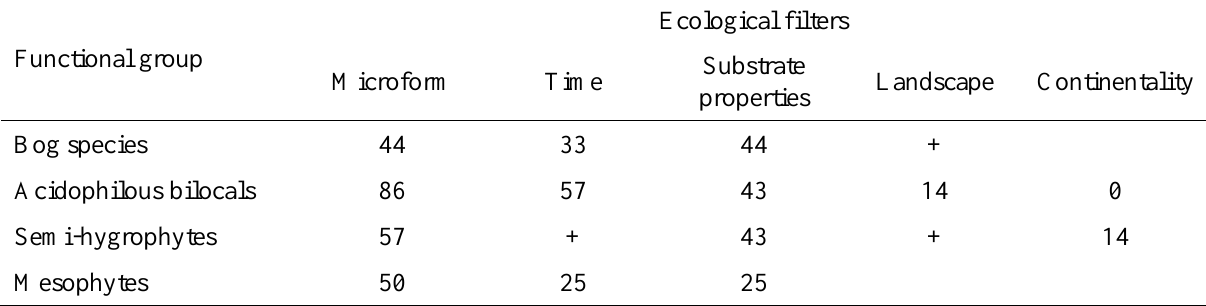
Table 3. Percent of core species models (Table 1) identifying the same filter effects as found in respective functional group models (Table 2). Additional filters only found in species models are labelled with